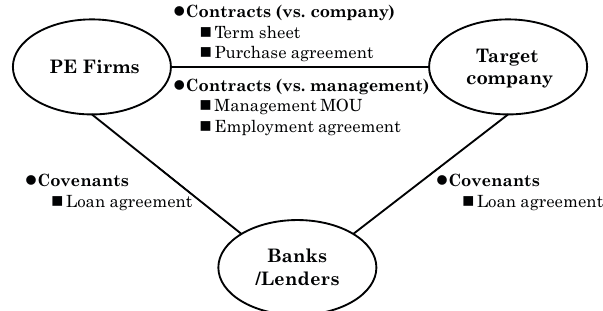
Fig. 1. A conceptual framework of covenants in a buyout